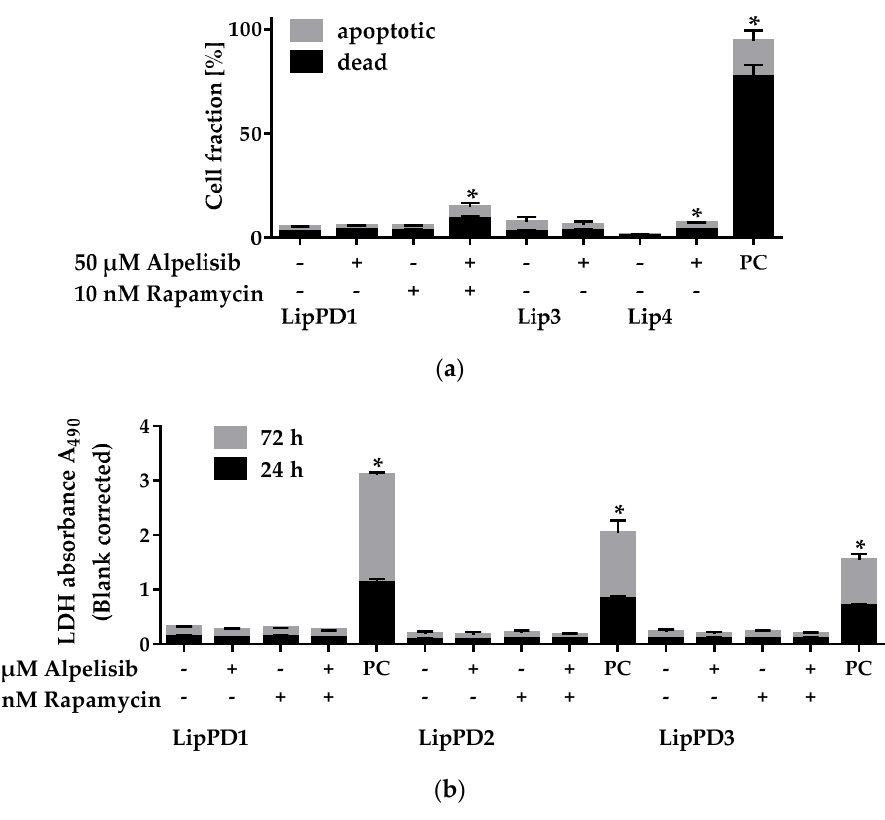
Figure 3. Apoptosis/cell death of PTEN Hamartoma Tumor Syndrome (PHTS, LipPD1-3) and PIK3CA-related overgrowth spectrum (PROS, Lip3-4) patients’ lipoma cells after 50 µM alpelisib and/or 10 nM rapamycin treatment. ( a ) Apoptotic/dead cells determined via annexin V/PI